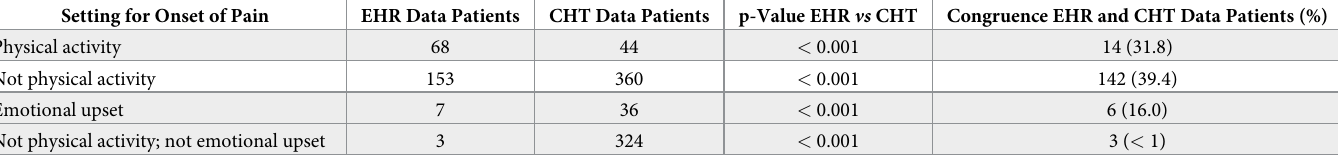
P-values are from a X 2 distribution table for one degree of freedom and X 2 calculated as in Methods. The denominator for percent congruence was the number of patients identified in CHT